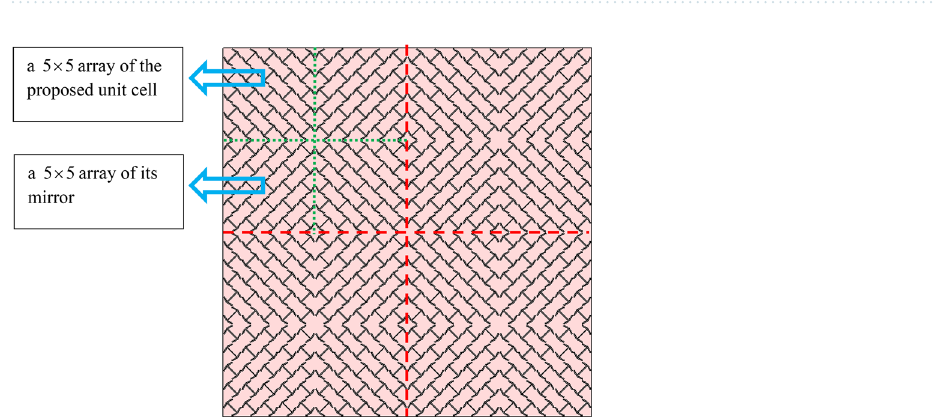
Figure 10. The surface current distribution on the ground sheet and resonator part of the proposed unit cell at frequency 10 GHz for ( a ) u-polarization and ( b ) v-polarization.